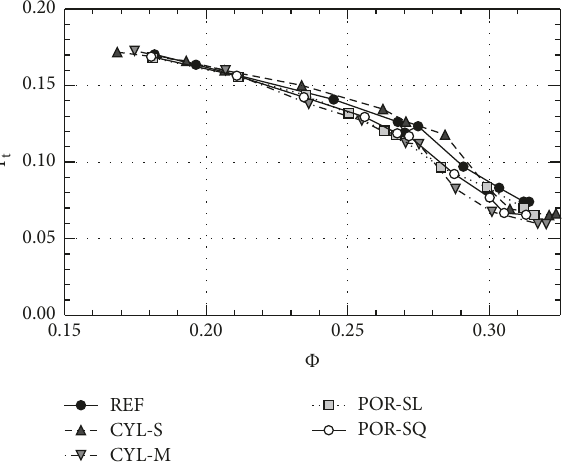
Figure 14: Influence of cylindrical shroud extensions ( 𝜇 = 0 ).